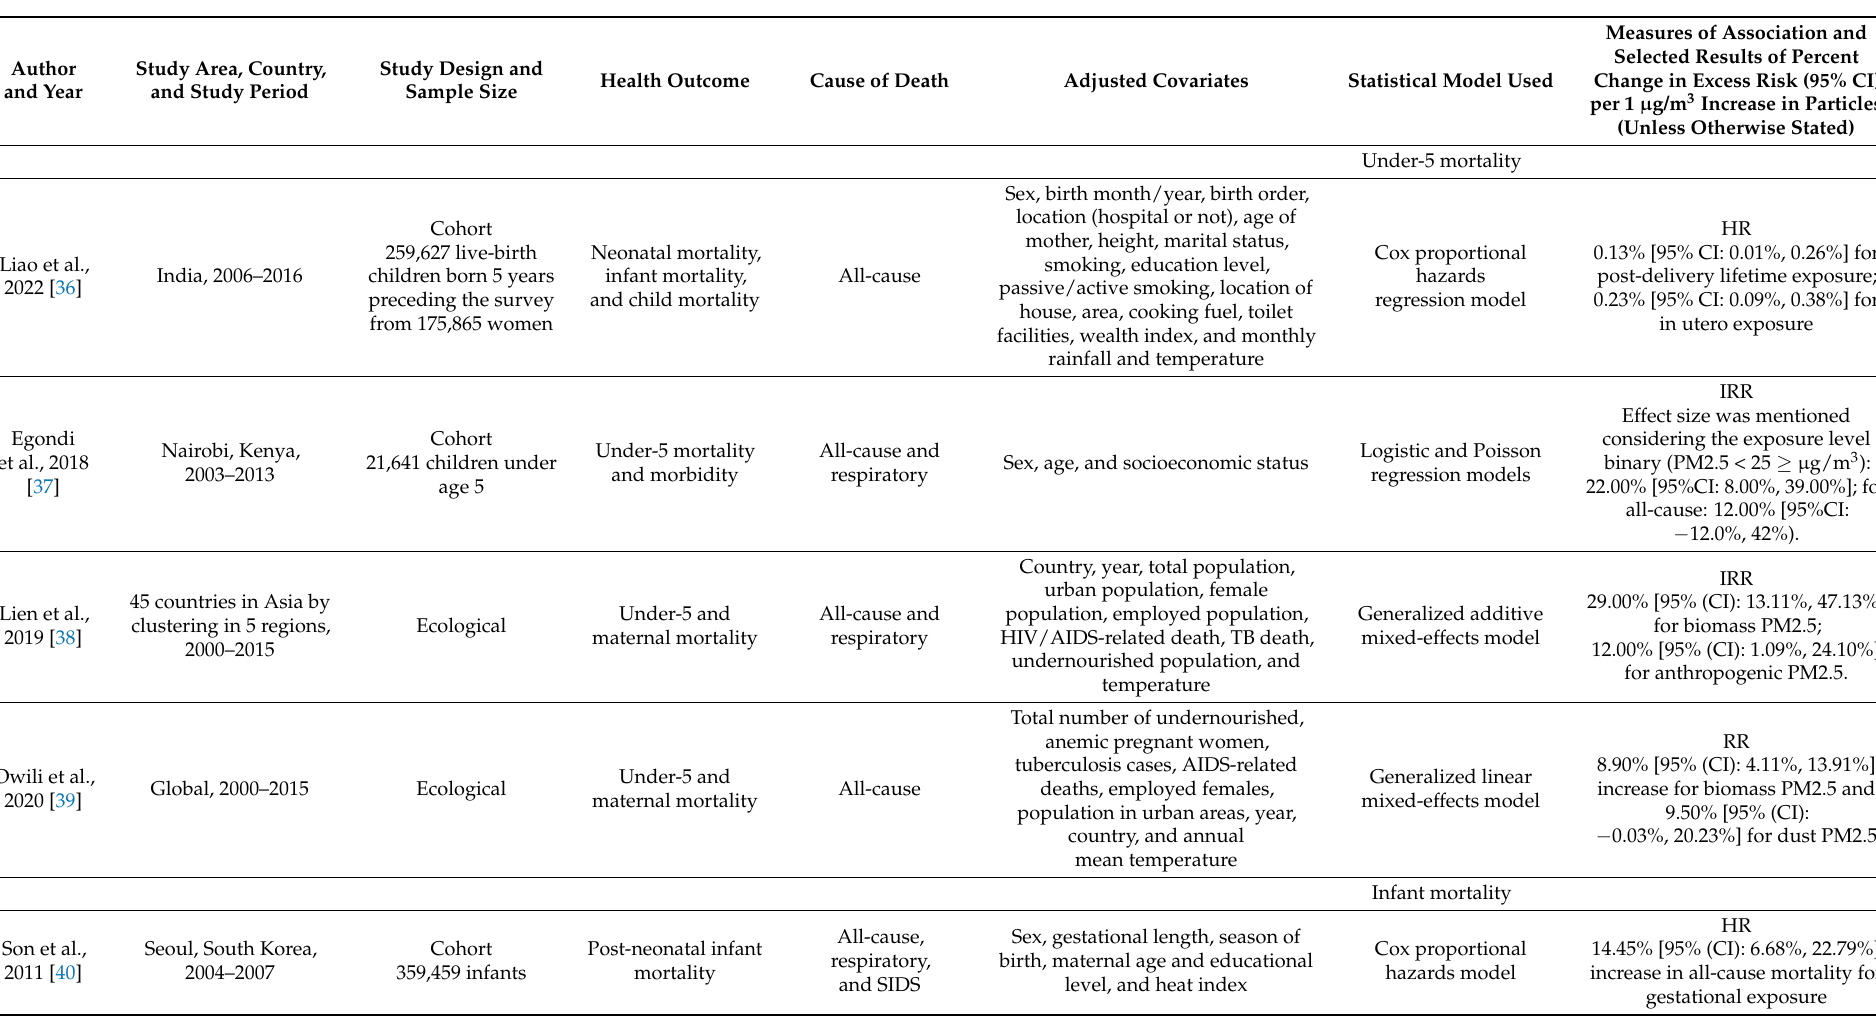
Table 1. Data extracted from the 13 selected